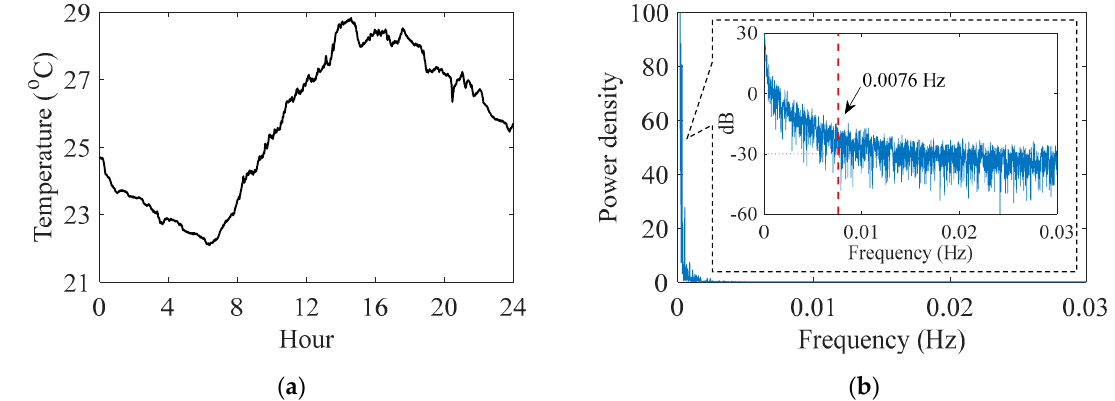
Figure 4. Atmospheric temperature and its frequency spectrum over the course of one day: ( a ) time history; ( b ) power density.